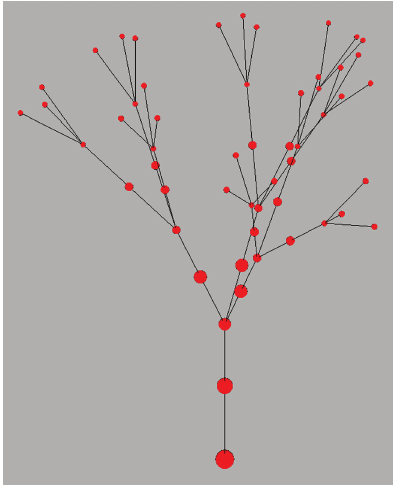
Figure 2: Geometrical model represented by BBSCs.